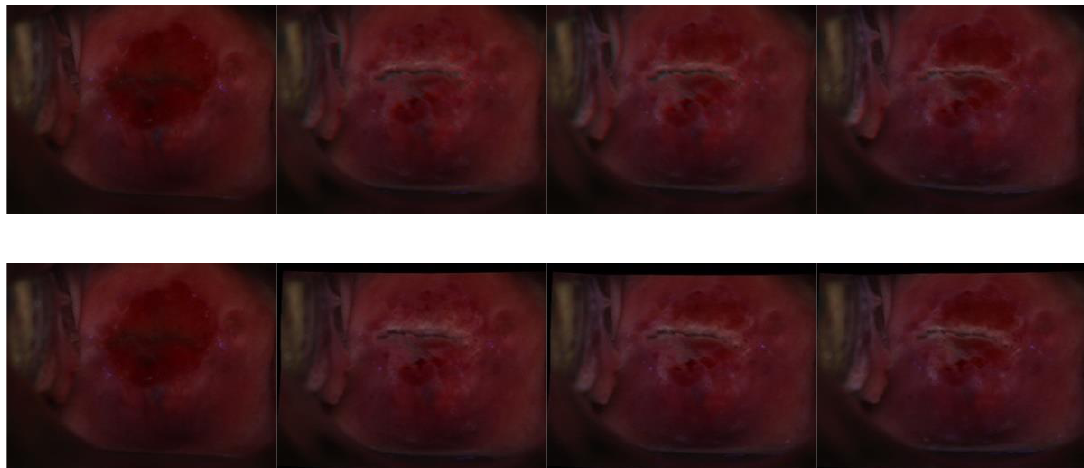
Figure 7. Registered time sequence image sample comparison between two methods. Images in the top row are from a time sequence registered by our approach; and the images in the bottom row are the same time sequence as registered by DYSIS [10]. The 1st image on the left of each row is the fixed image, and each image toward the right side in each row demonstrates the 6th, 12th, and 17th registered sample in that time sequence. Image distortion and defects can be observed in the bottom-row images, on edges and corners.